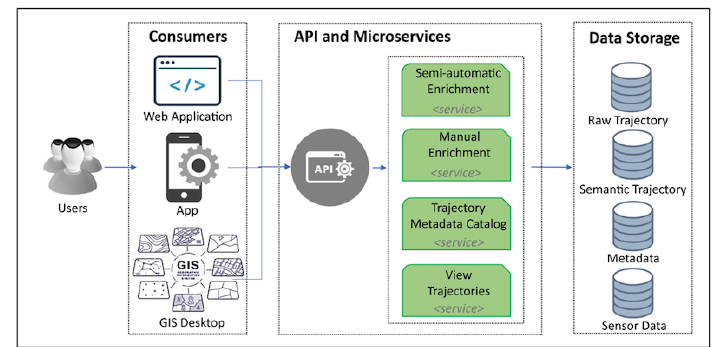
Figure 3. A System Architecture for STMO-enabled